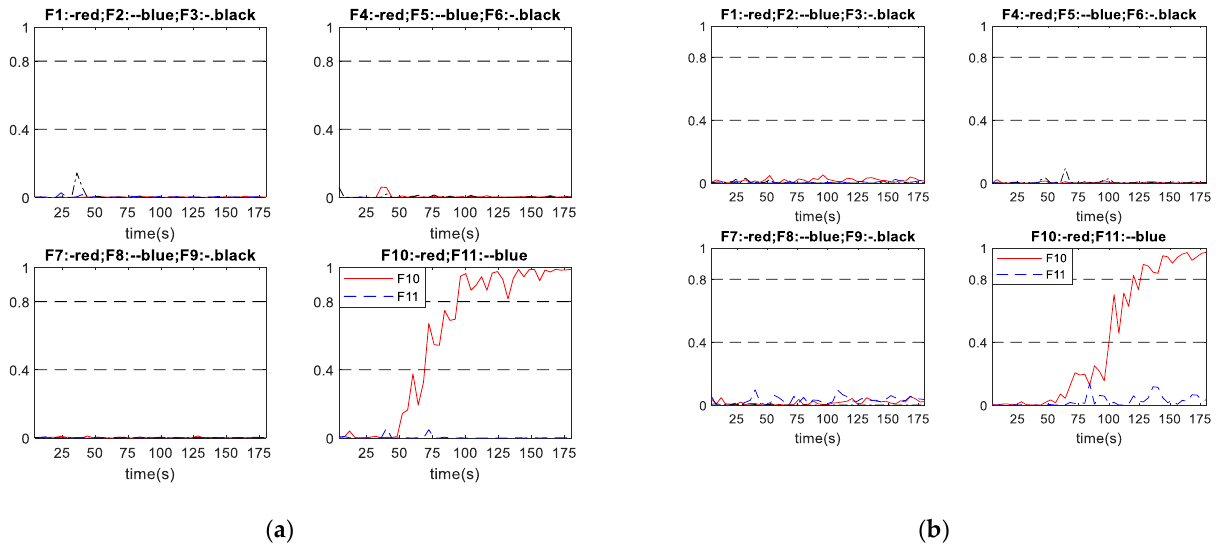
Figure 12. Diagnosis performance of scheme A ( a ) and scheme B ( b ) under incipient fault No. 10 with developing speed of 6.71 × 10 −5 (s −1 ).